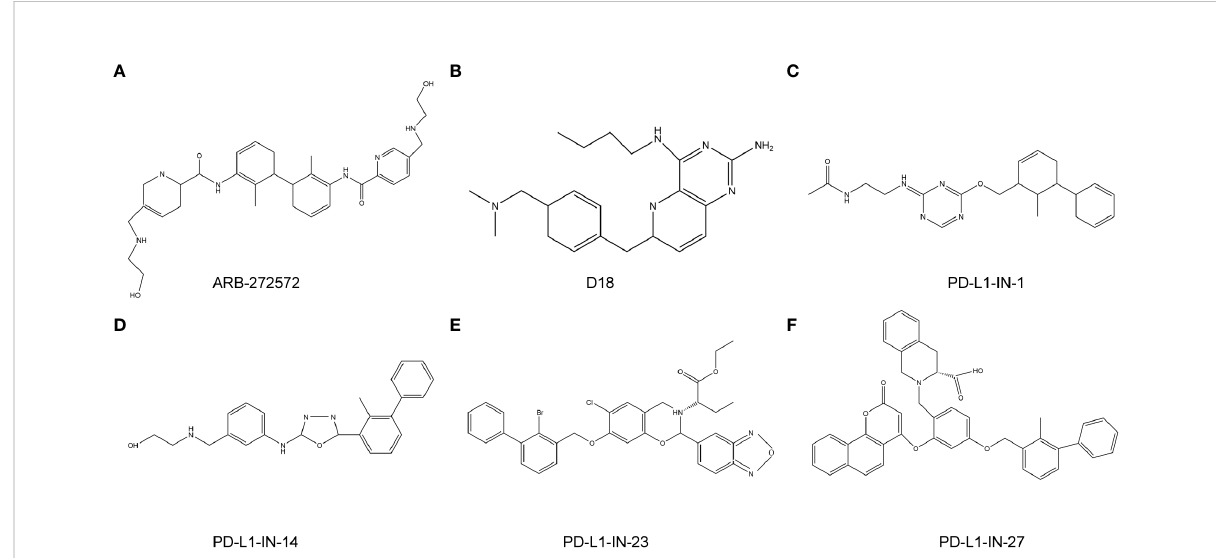
FIGURE 6 anti-PD-L1 targeted chemotherapy drugs. (A) , ARB-272572; (B) , D18; (C) , PD-L1-IN-1; (D) , PD-L1-IN-14; (E) , PD-L1-IN-23; (F) ,